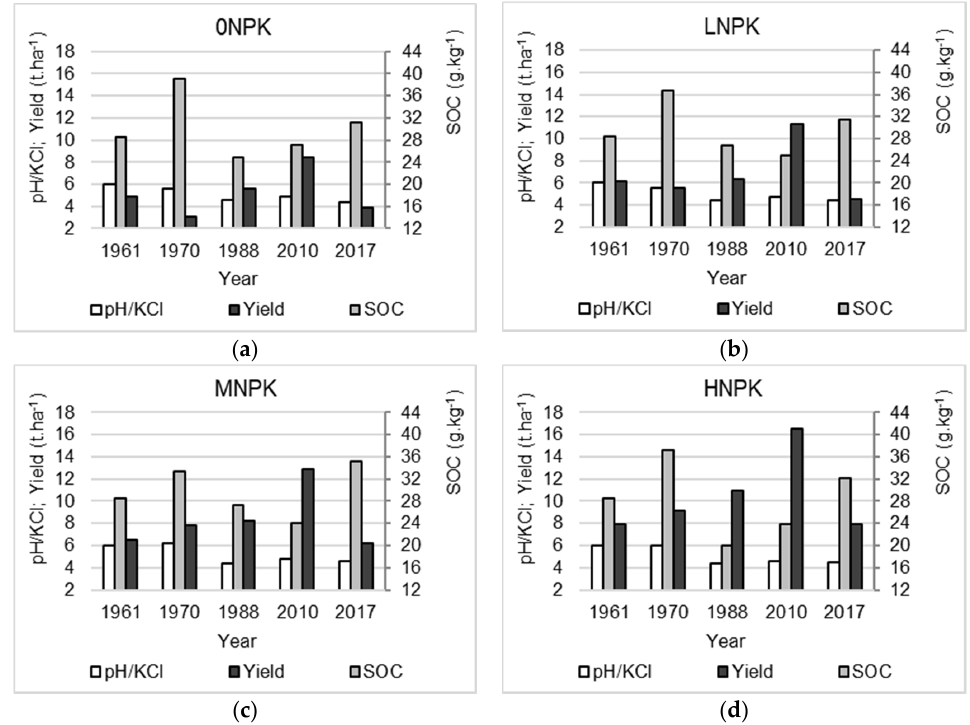
Figure 4. Changes in soil chemical properties and plant yield under the different NPK addition: ( a ) 0NPK; ( b ) low NPK treatment (LNPK); ( c ) medium NPK treatment (MNPK); ( d ) high NPK treatment